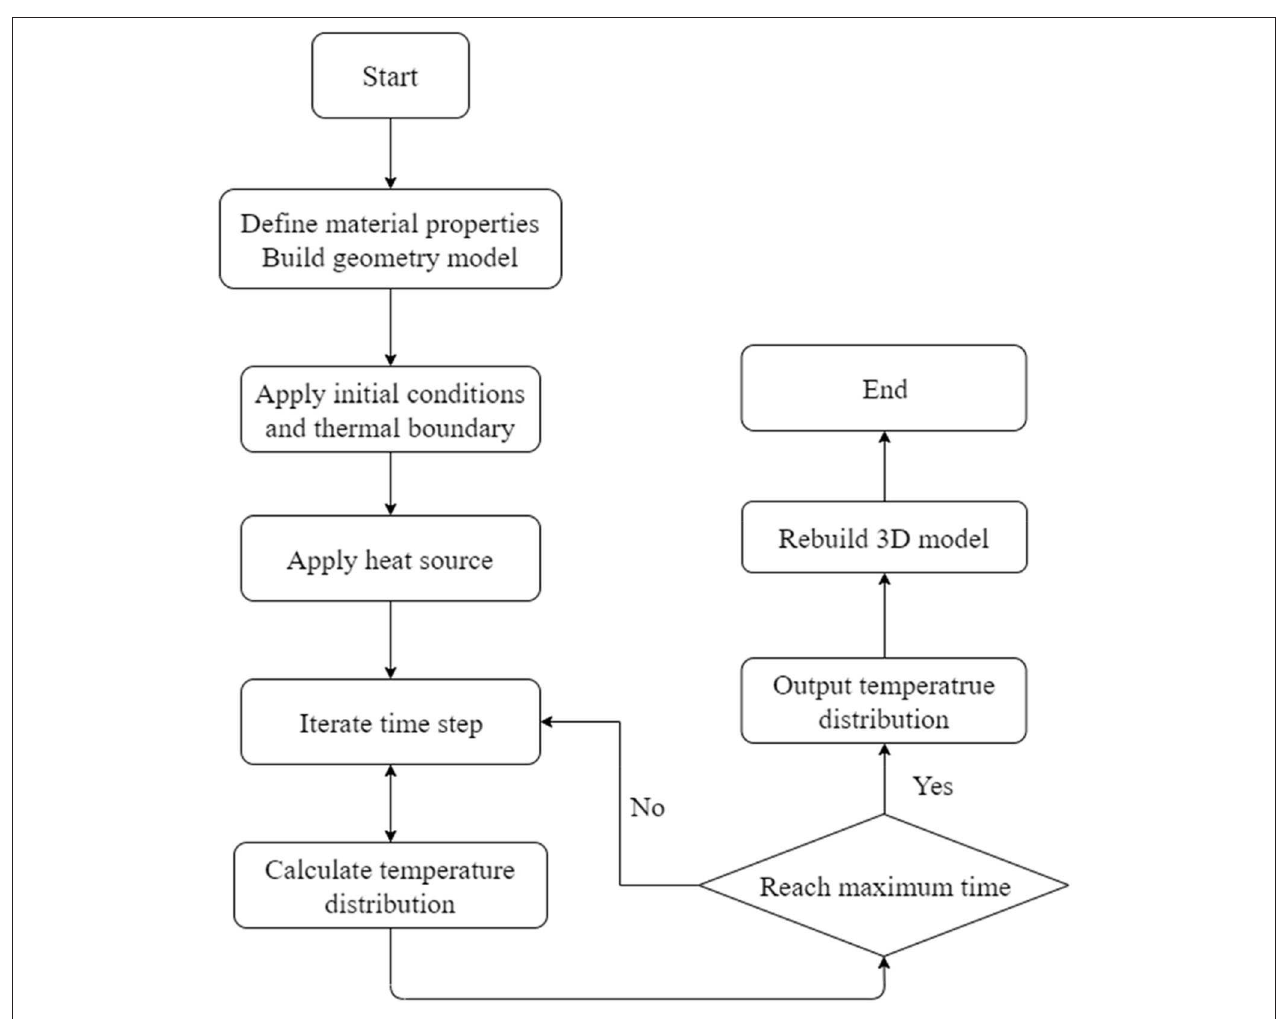
FIGURE 4 | Simulation flow chart (Zhong et al.,